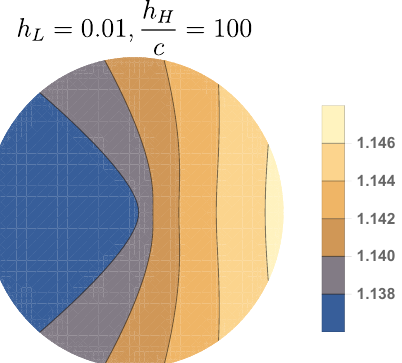
semi Figure 5 . This is a plot of zoomed in to the tip of the Euclidean ‘cigar’, with r + < r < 0 j jV 1 : 025 r + and 0 < t E < (cid:12) . The radial coordinate of the disk is r 2 (cid:25) t E ; the BTZ angular coordinate (cid:18) = 0. The center of the plot is the position of the Euclidean (cid:12) semi horizon and r + 49. Notice that is smooth everywhere in this plot, in contrast to 0 j (cid:25) jV in (cid:12)gure 6 below.